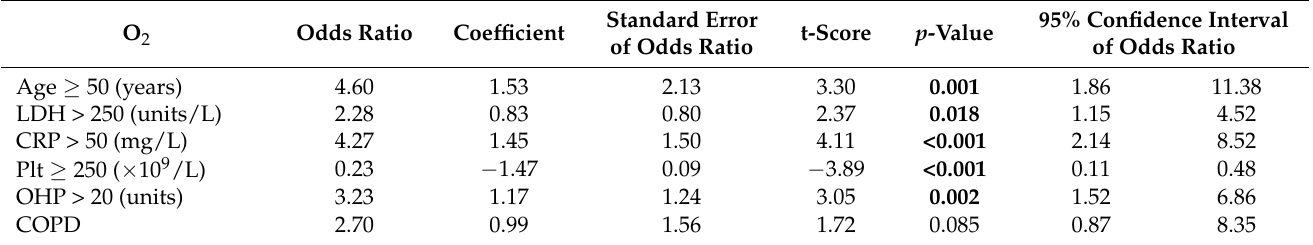
Table 5. Multivariate logistic model for prediction of oxygen requirement in COVID-19 patients from